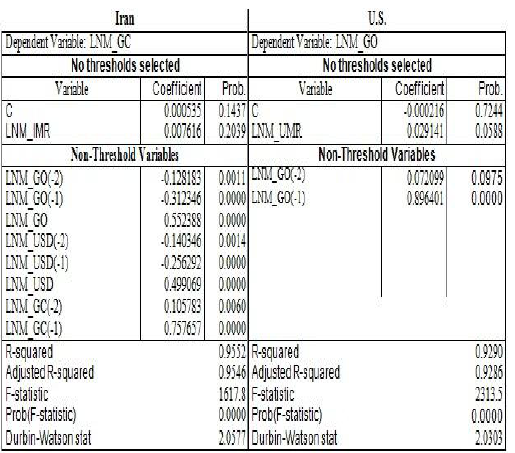
Table 8: Manually Applying the Regimes to the Relationship of the Weekly Return of the U.S. and Iran Stock Markets with Gold Method: Threshold Regression